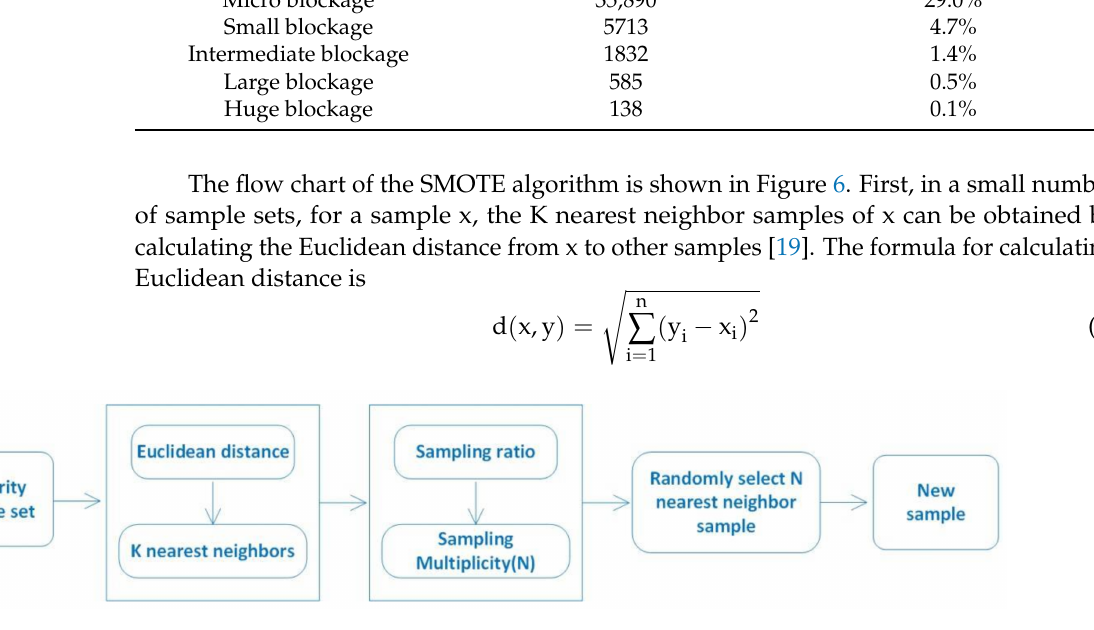
Figure 6. Flow chart of SMOTE algorithm.